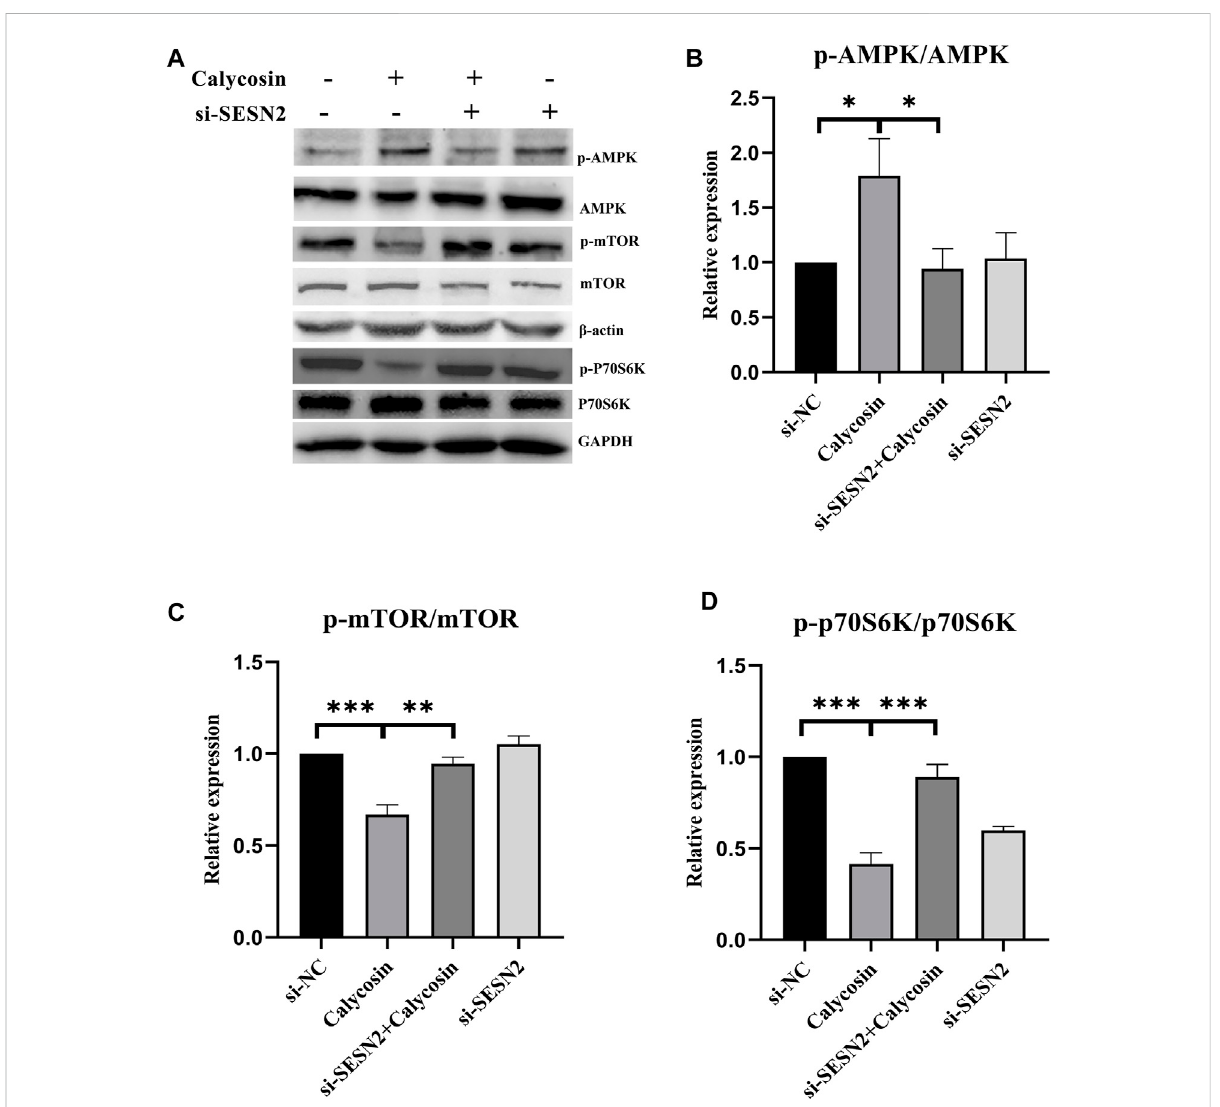
FIGURE 7 The pharmacological action of calycosin was through the SESN2-AMPK-mTOR pathway. The levels of p-AMPK/AMPK (A,B) , p-mTOR/mTOR (A,C) and p-p70S6K/p70S6K (A,D) proteins in si-NC, si-SESN2/calycosin (100 μ M)-treated B-CPAP cells. Results are representative of